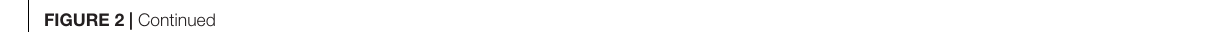
( Table 1 ). In pigs vaccinated with 50 µ g of ppE2, a positive reaction was observed only on day 7 post-challenge. No